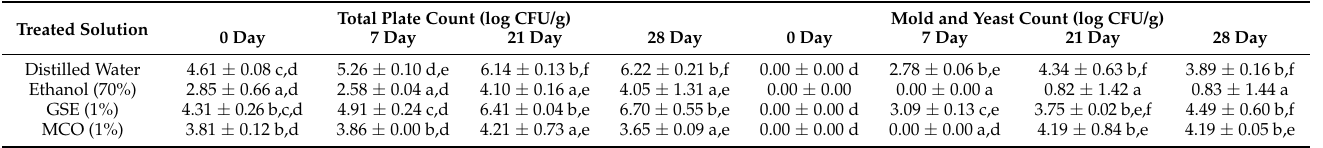
Table 1. Total plate counts and mold and yeast counts of rice cake during storage.